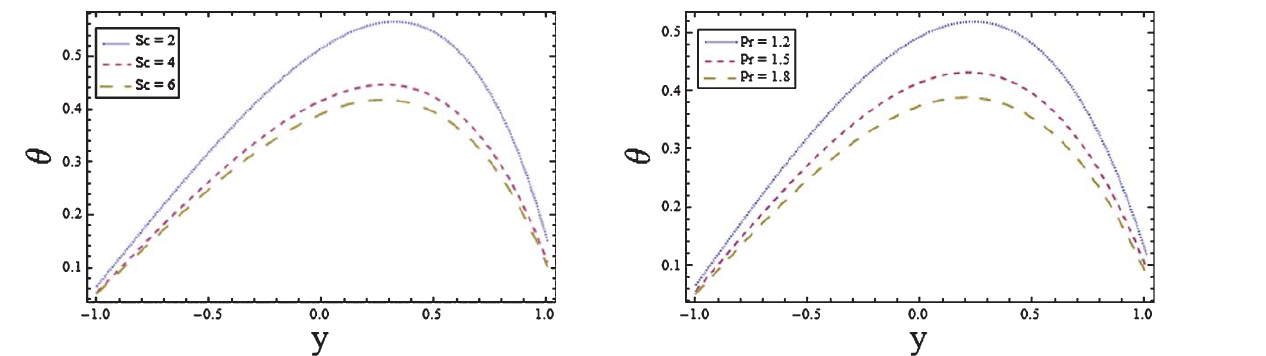
Fig. 11. Plot of the temperature θ for various values of the Prandtl number Pr with (cid:15) = 0 . 2, x = 0 . 1, t = 0 . 1 Sc = 0 . 4 , Sr = 1 . 8 , Du = 1 . 8 , γ = 10 , γ = − 1 . 5 and γ = 8 . 1 2